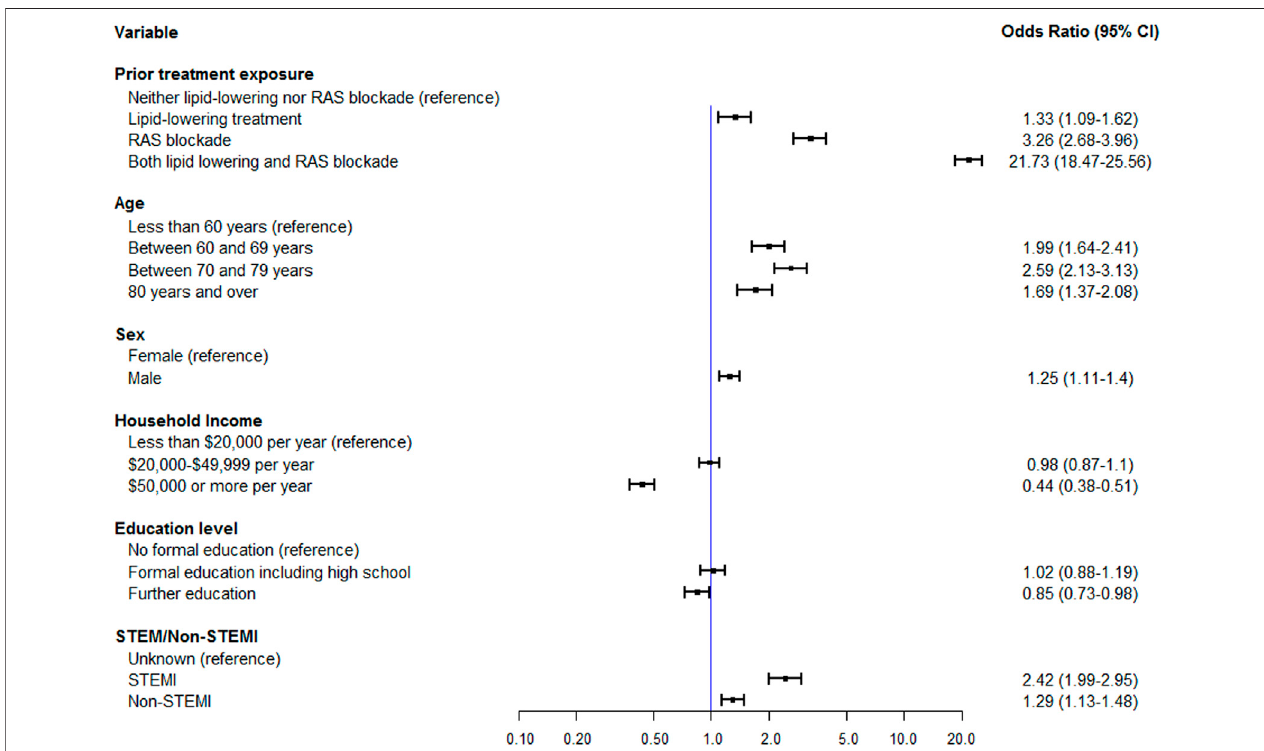
FIGURE 3 | Multivariable logistic regression of adherence at 12 months post AMI by prior treatment exposure including age, sex, income, education level and STEMI/Non-STEMI status.